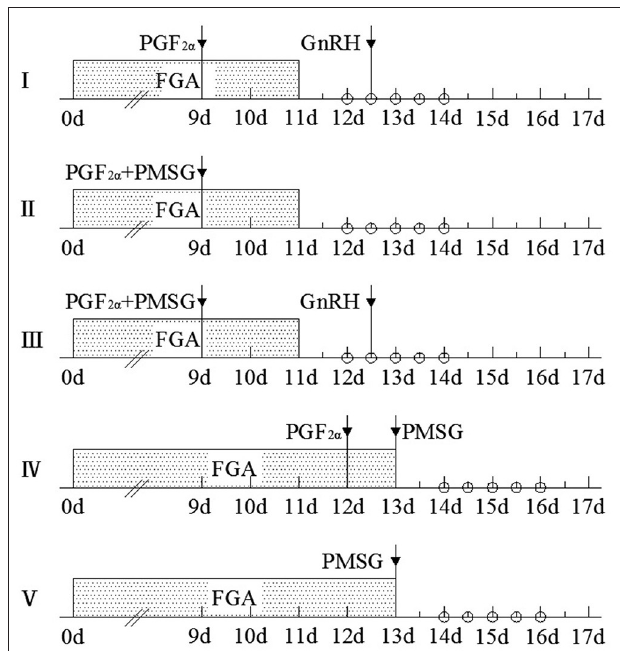
FIGURE 1 | Five protocols of estrous synchronization and the time frame of treatments in ewes. The beginning of fluorogestone acetate (FGA) use was recorded as 0 days, and shadow represents the continuous use of the FGA vaginal suppository. The time indicated by the arrow is the specific time of the use of various hormones in each protocol. FGA vaginal suppository contained 45mg of fluorogestone acetate, and the intramuscular dose of PGF 2 α , PMSG, and GnRH was 0.1mg, 330 IU, and 6 µ g, respectively. “ ◦ ” refers to the time points of 24, 36, 48, 60, and 72h after the sponge removal, and the number of estrous ewes was recorded at these time